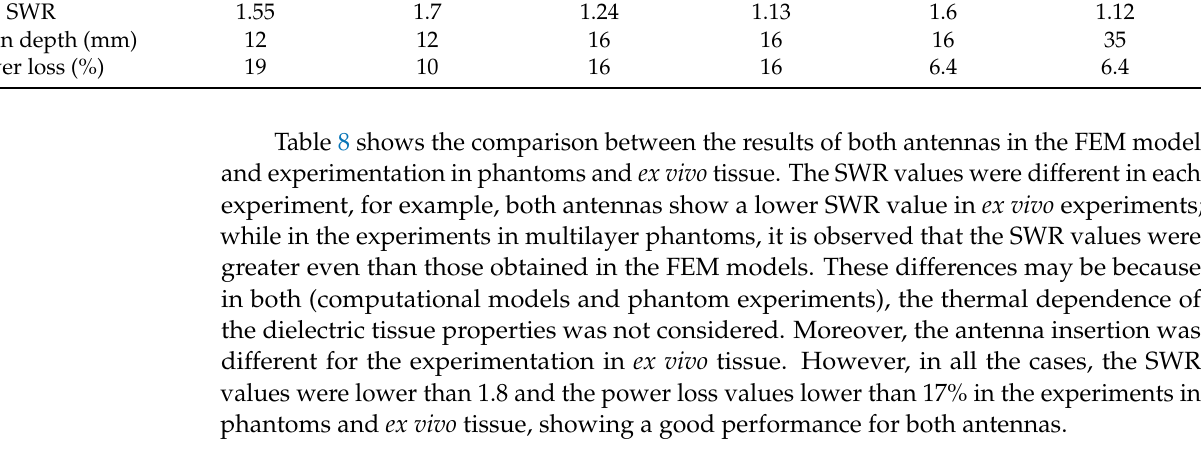
Table 8. Comparison between computational models, multilayer phantom and ex vivo experiments for MTM and CDS antennas using 5 W per 5 min. MTM Antenna CDS Antenna Parameter FEM